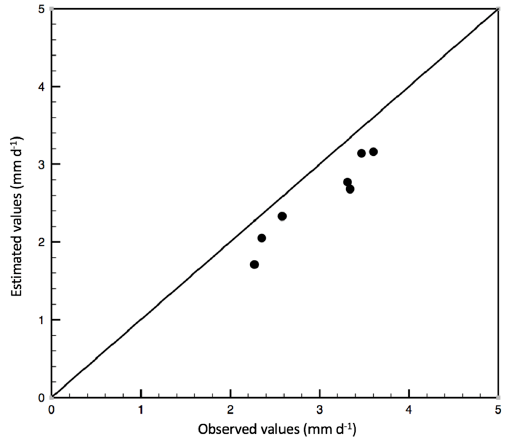
Figure 4. Comparison between estimated and observed values of daily actual evapotranspiration of a drip irrigated olive orchard. (ET sw ). Index of agreement (I a ) for ET sw was equal to 0.95. This comparison was done using days when satellite images were available.